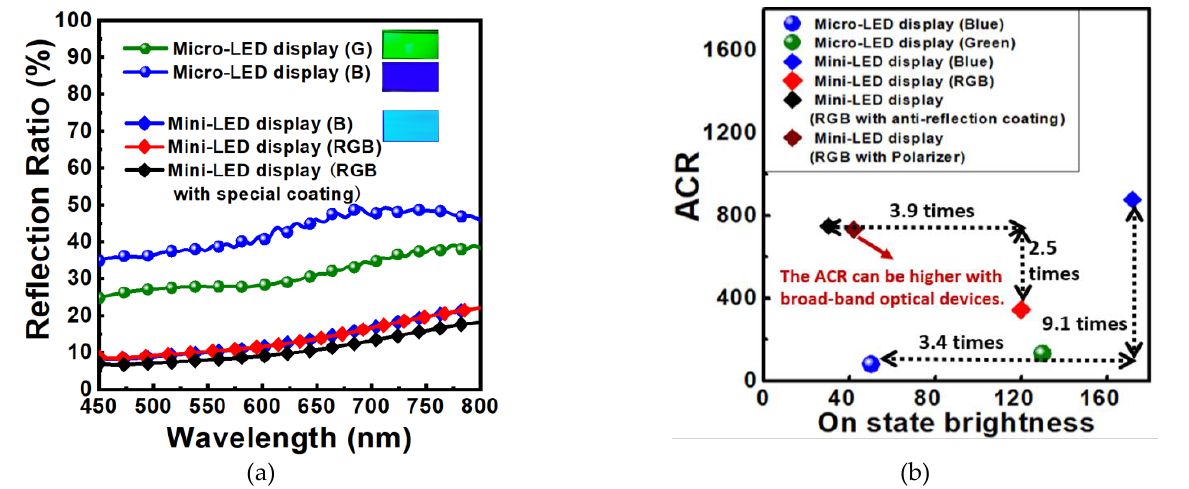
Figure 6. ( a ) reflection spectrum and ( b ) The ambient contras ratio versus on state brightness (knits) of different mini-LED and micro-LED panels.